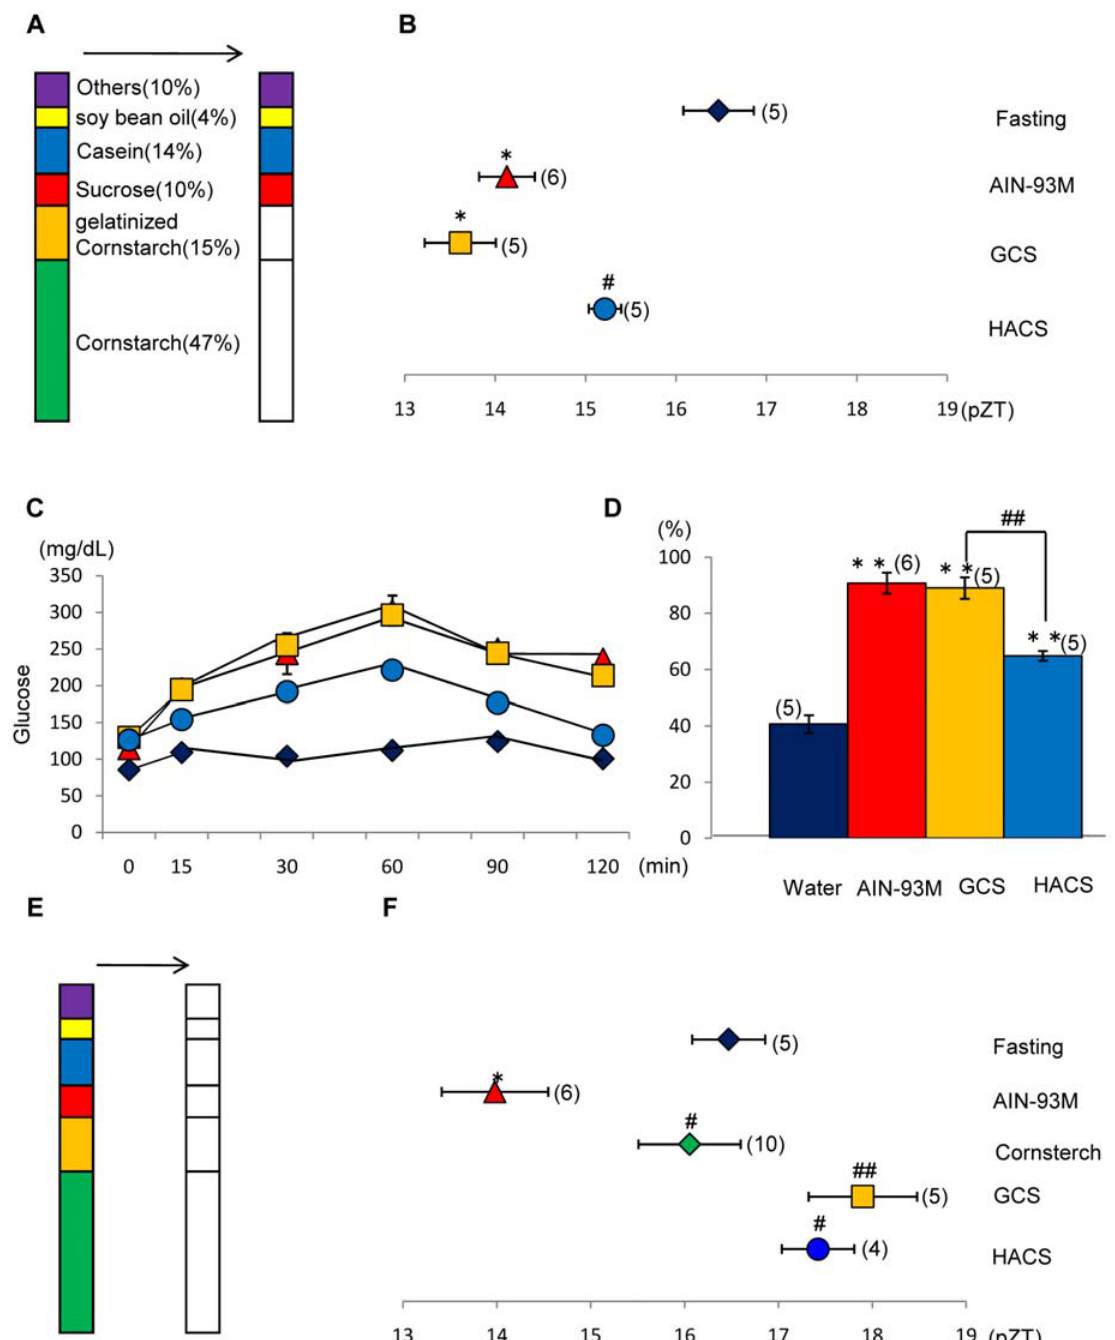
Figure 4. Effects of the substitution of cornstarch in AIN-93M by gelatinized cornstarch (GCS) or high-amylose cornstarch (HACS) on the phase of the liver circadian clock and relative blood glucose value. A: Percent component of each nutrient in AIN-93M. Substituted components are shown by the white column segments. B: Mice were administered a diet tablet containing 0.6 g/10 g BW of the substituted diet on the first day and 0.85 g/10 g BW of the substituted diet on the second day after 24-h food deprivation. The components of cornstarch and GCS in AIN-93M were replaced with GCS or HACS. The horizontal axis indicates the pZT at the peak of the bioluminescence rhythm. Fisher’s PLSD test. * P , 0.05 (vs. fasting). # P , 0.05 (vs. GCS). C: Time course of the blood glucose level after oral injection of 0.03 g/10 g BW of each substituted nutrient. The vertical axis indicates the content of glucose (mg/dL). The values indicate the mean 6 SEM. Symbol color of each treatment is same as column color in part D. D: Relative blood glucose value (% of glucose) of the nutrient-substituted group. Fisher’s PLSD test. ** P , 0.01 (vs. water), ## P , 0.01 (vs. GCS). The numbers in parentheses indicate the number of tested mice. E: Percent component of each nutrient in AIN-93M. Substituted components are shown by white column segments. F: All nutrient components in AIN-93M were completely substituted with 100% cornstarch, 100% GCS, or 100% HACS. The horizontal axis indicates the pZT at the peak of the bioluminescence rhythm. Fisher’s PLSD test. * P , 0.05 (vs. fasting); fasting, 2-day fast # P , 0.05, ## P , 0.01 (vs. AIN-93M). The numbers in the parentheses indicate the number of tested mice. We used the same data of fasting or 100% cornstarch as mentioned in Fig. 2 to produce Fig. 4.